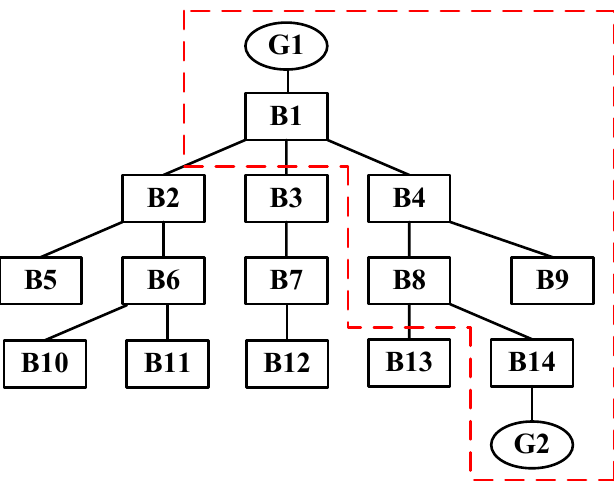
Figure 1. The formation of virtual coherent